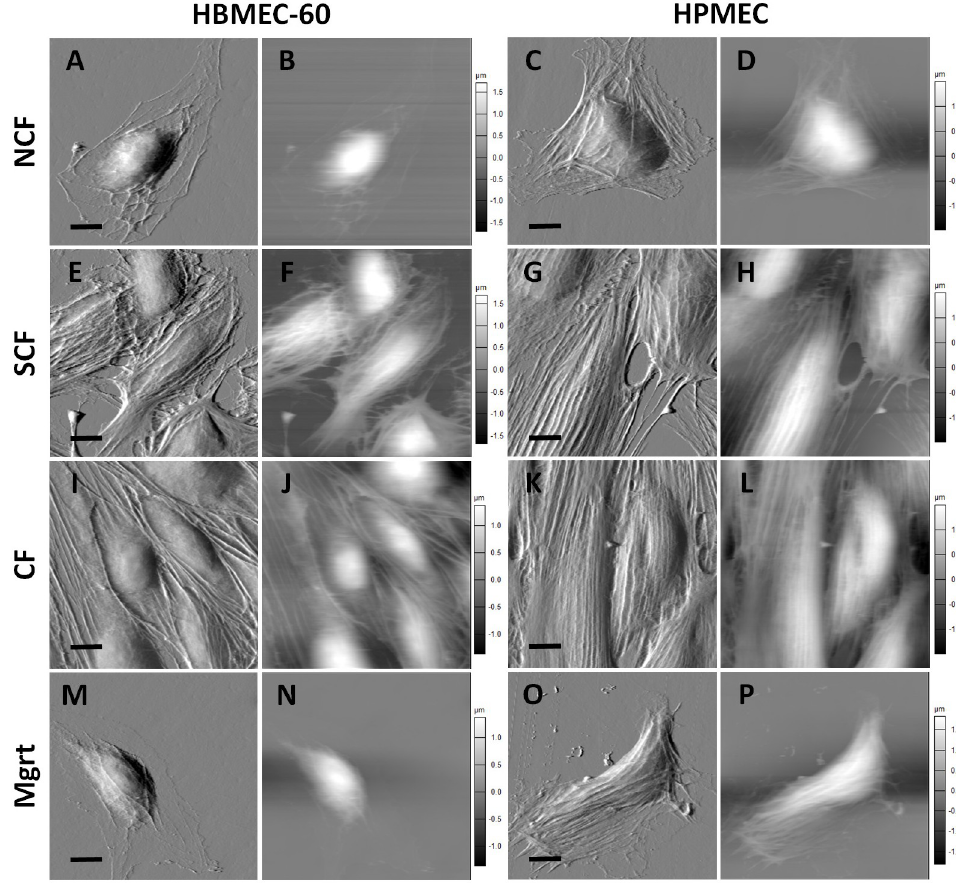
Fig 5. Representative topography imaging (60 μ m x 60 μ m) of ECs at different growing states. Cantilever deflection images (A, E, I and M for HBMEC-60; C, G, K and O for HPMEC) and cell height images (B, F, J and N for HBMEC-60; D, H, L and P for HPMEC) on ECs were performed to visualize the EC cytoskeletal structure underneath cell membrane. Both HBMEC-60 (E and I) and HPMEC (G and K) cells at SCF state revealed denser, thicker and more aligned stress fiber networks, compared to their respective NCF (A and C) states. The Mgrt (M) cell in HBMEC-60 showed less stress fibers than the NCF (A) cells, while in HPMEC, the Mgrt (O) cells retained more fibers inside the cell. There were no remarkable changes seen in cell height as a function of confluency in either HBMEC-60 (B, F, J and N) or HPMEC (D, H, L and P). Gray vertical scale bars ( μ m) are for cell height. Black scale bars = 10 μ m.